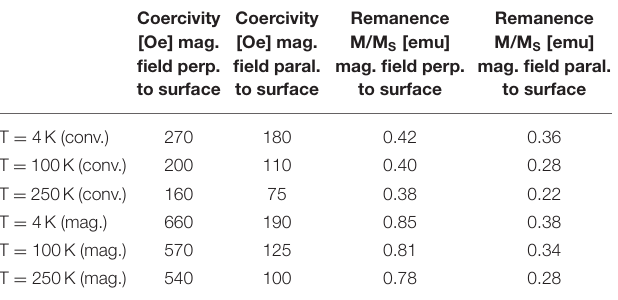
TABLE 2 | Magnetic features measured at T = 4, 100K and T = 250K summarized for conventional etched samples and magnetic field assisted etched ones.